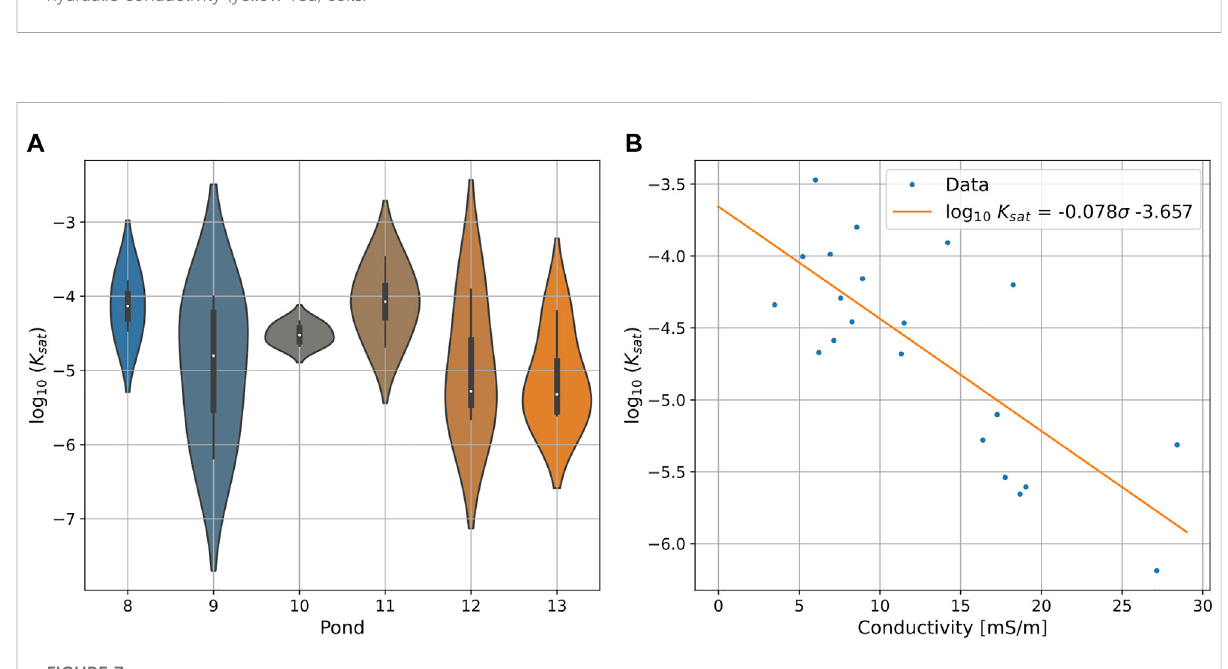
FIGURE 7 (A) Distributions of saturated hydraulic conductivity for each pond. (B) Linear relationship linking electrical conductivity to hydraulic conductivity.